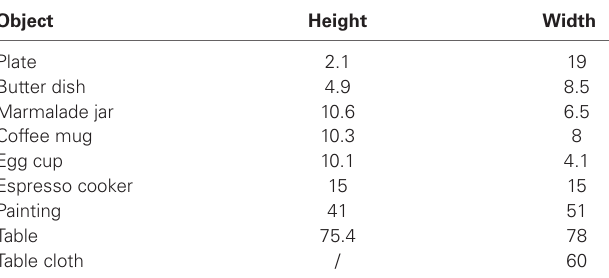
Table 1 | Maximum height and width of objects in the scene in cm